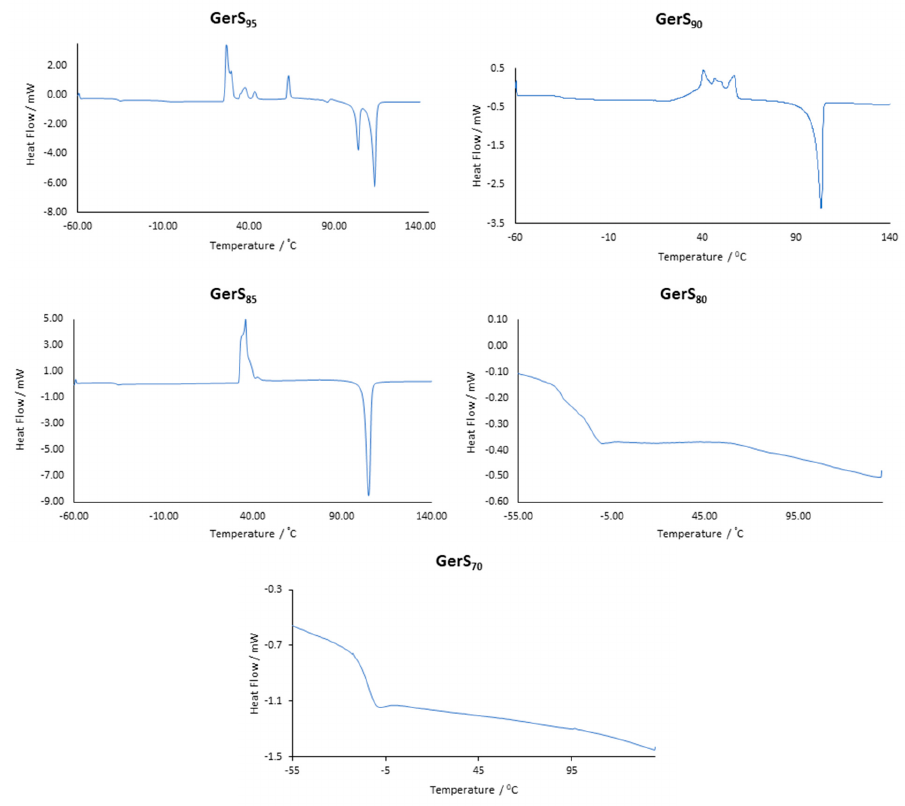
Figure 2. DSC traces for the third heating curves for GerS x . Analogous traces for the FarS x series of composites are provided in the Supplementary Materials (Figure S1).